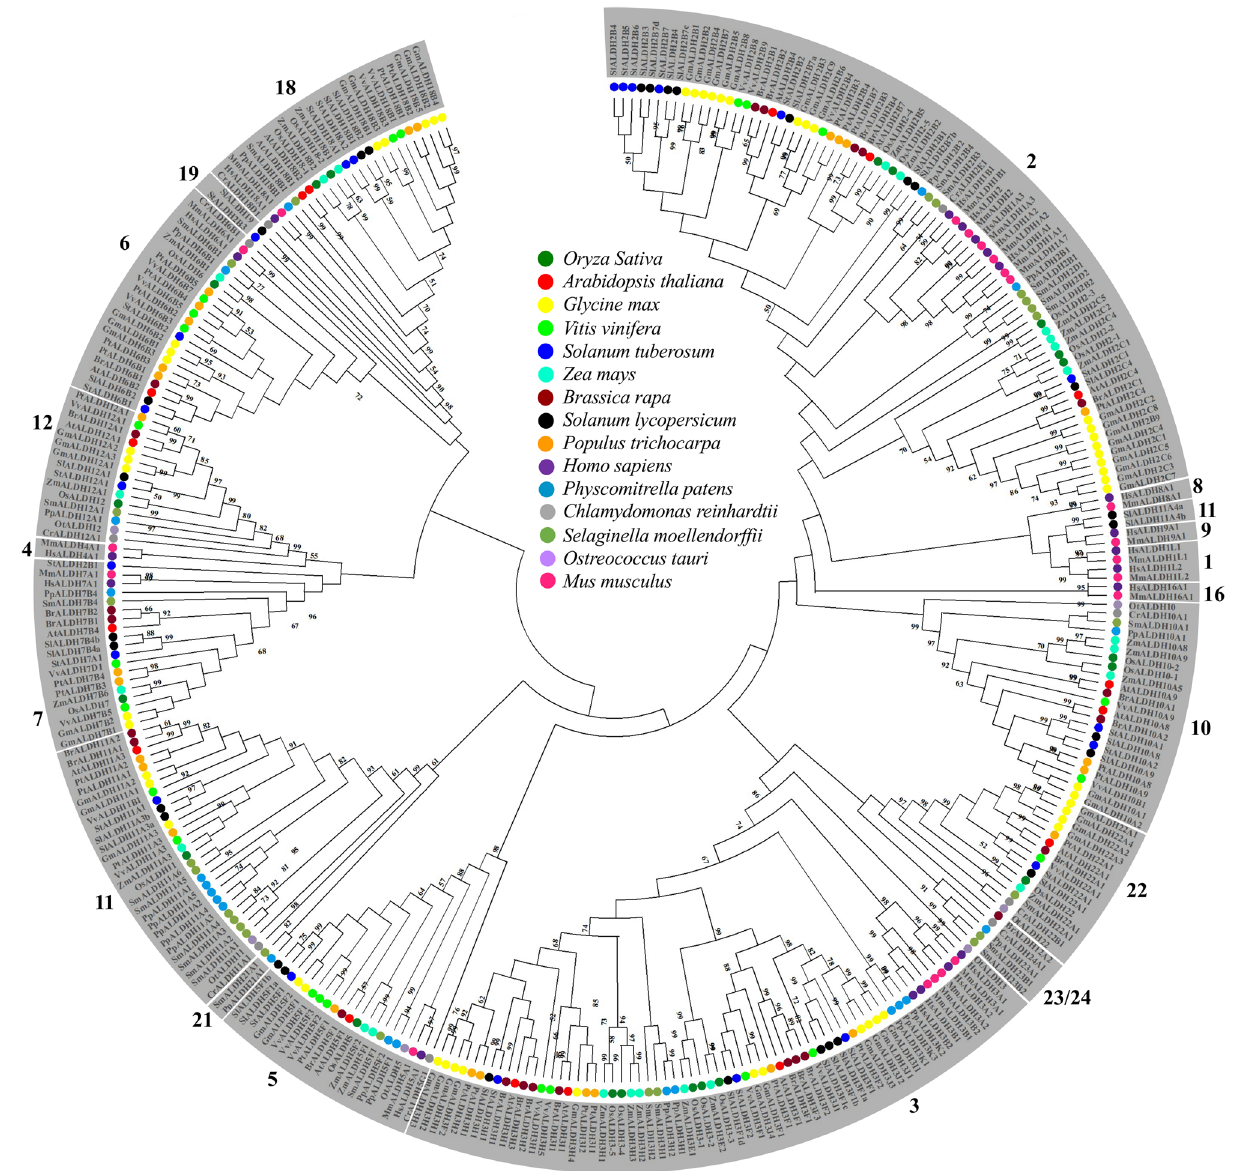
Figure 4. Phylogenetic analysis of potato ALDH members. ALDH proteins from various species including Arabidopsis , rice, soybean, maize, field mustard, grape, potato, tomato, black cottonwood, moss, green algae, mouse, and human were collected from databases. A total of 335 protein sequences from 12 different species were aligned by ClustalW followed by the construction of a maximum-likelihood tree using MEGA X (https:// www. megas oftwa re. net/) with 1000 bootstrap replicates. Bootstrap values greater than 50 were shown in the different branching points of the tree indicating significant clustering. ALDH members from different species were indicated by a different colour and summarized in the middle of the tree. The tree was divided into 11 families based on their clustering pattern and individual ALDH family number was